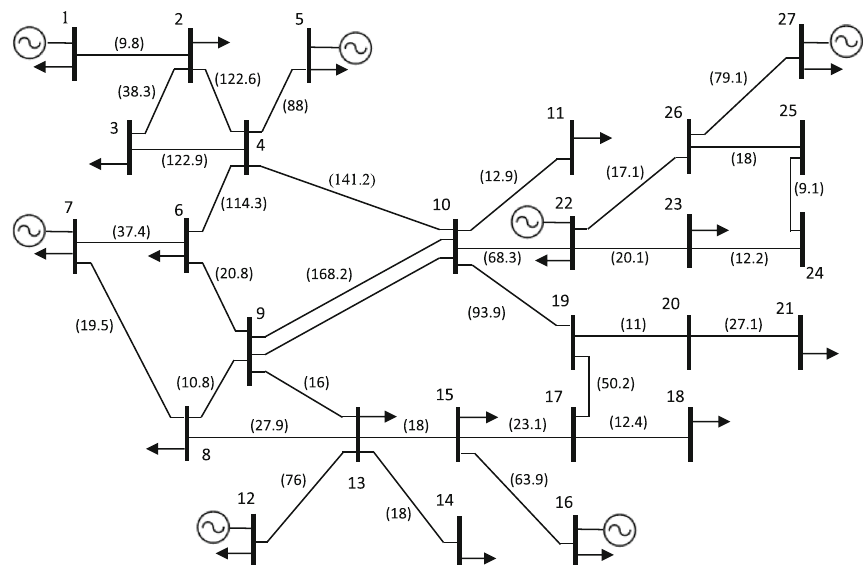
Fig. 3 The 27-bus transmission system used for